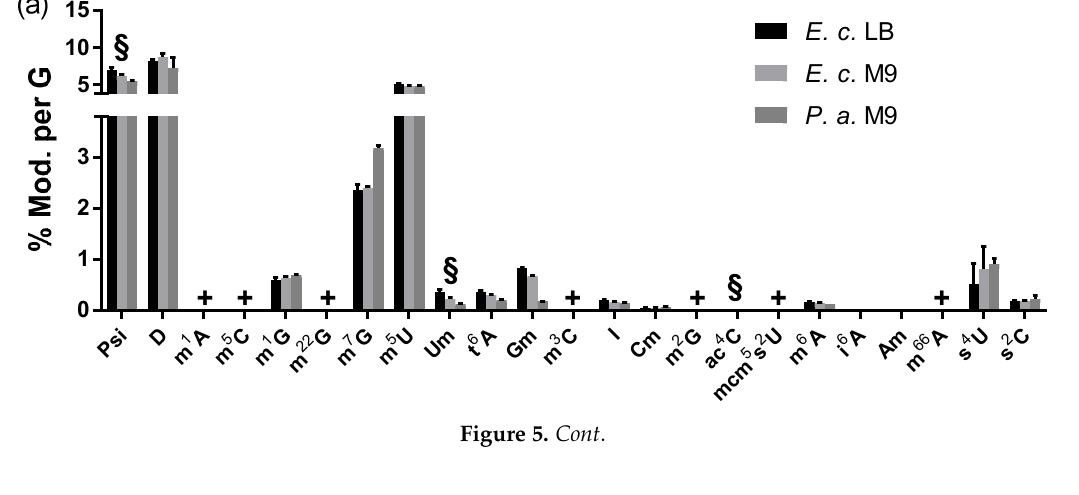
Figure 5 . Cont Figure 5. Cont